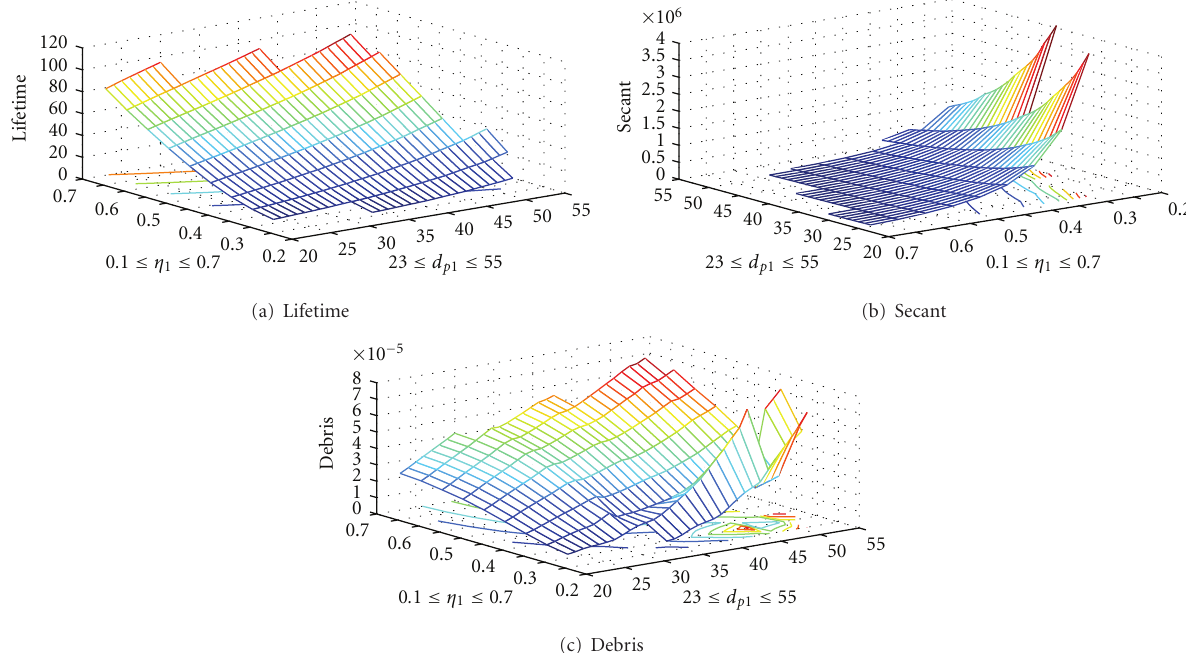
Figure 5: Landscapes with η 2 = 0 . 65, d p 2 = 24 μ m while η 1 , d p 1